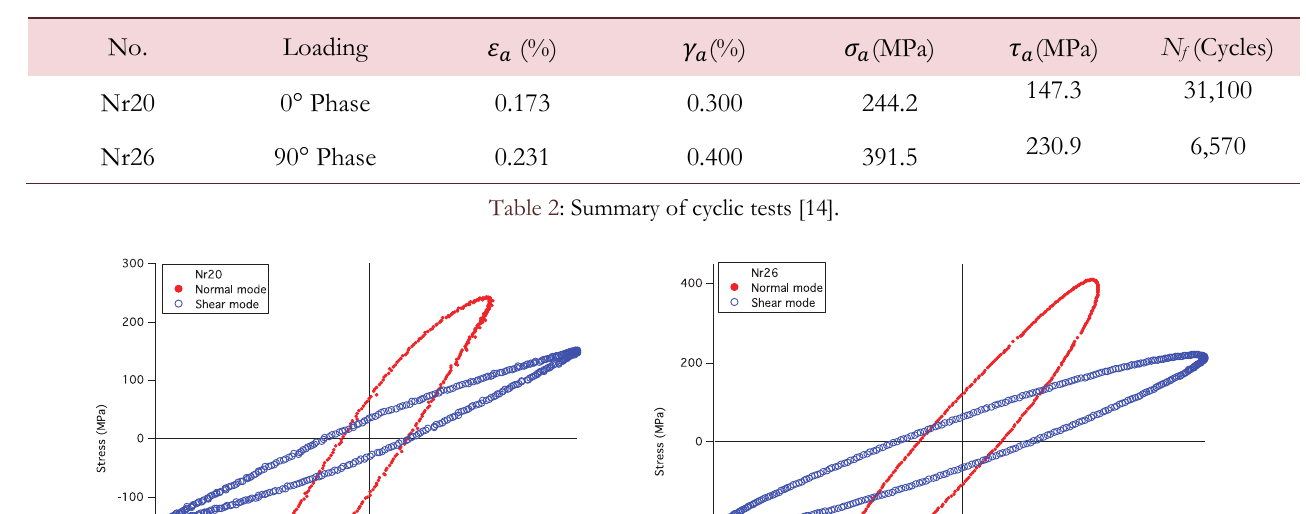
Table 1: Monotonic and cyclic properties of S460N steel [14].